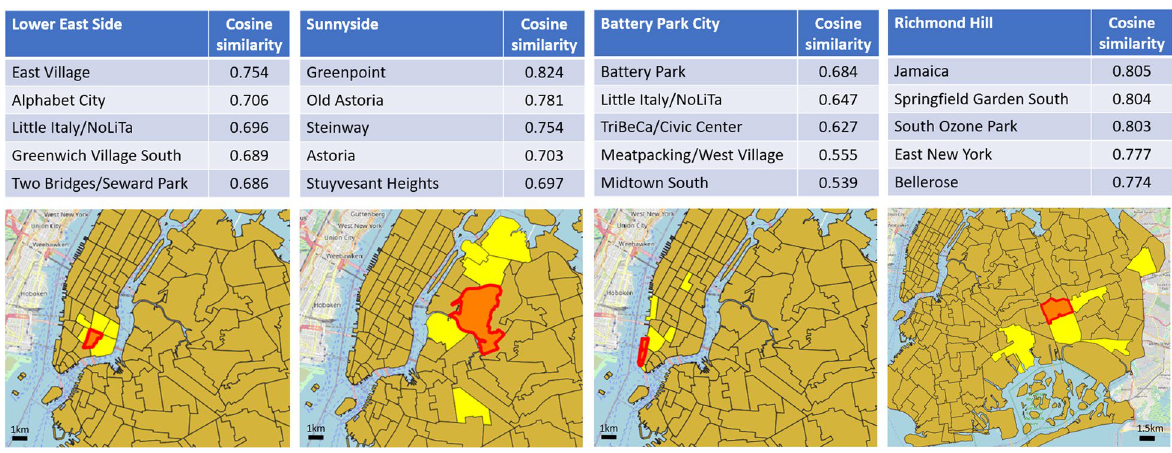
Fig. 4 Four examples of top five similar areas (yellow regions), in terms of cosine similarity score, of a chosen reference area (red